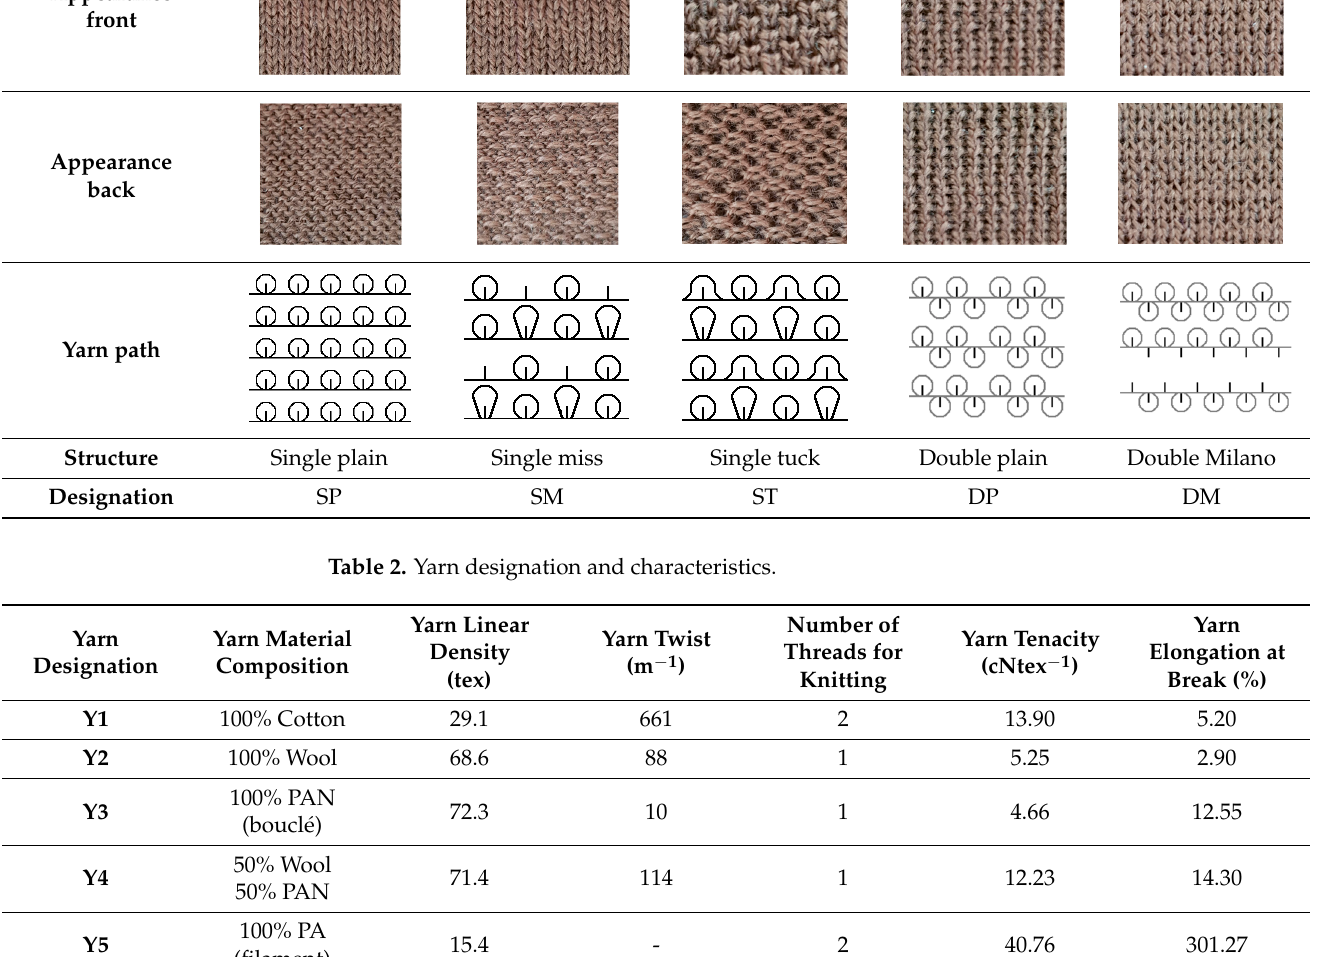
Table 1. Single and double knitted structures selected for the knitted samples.